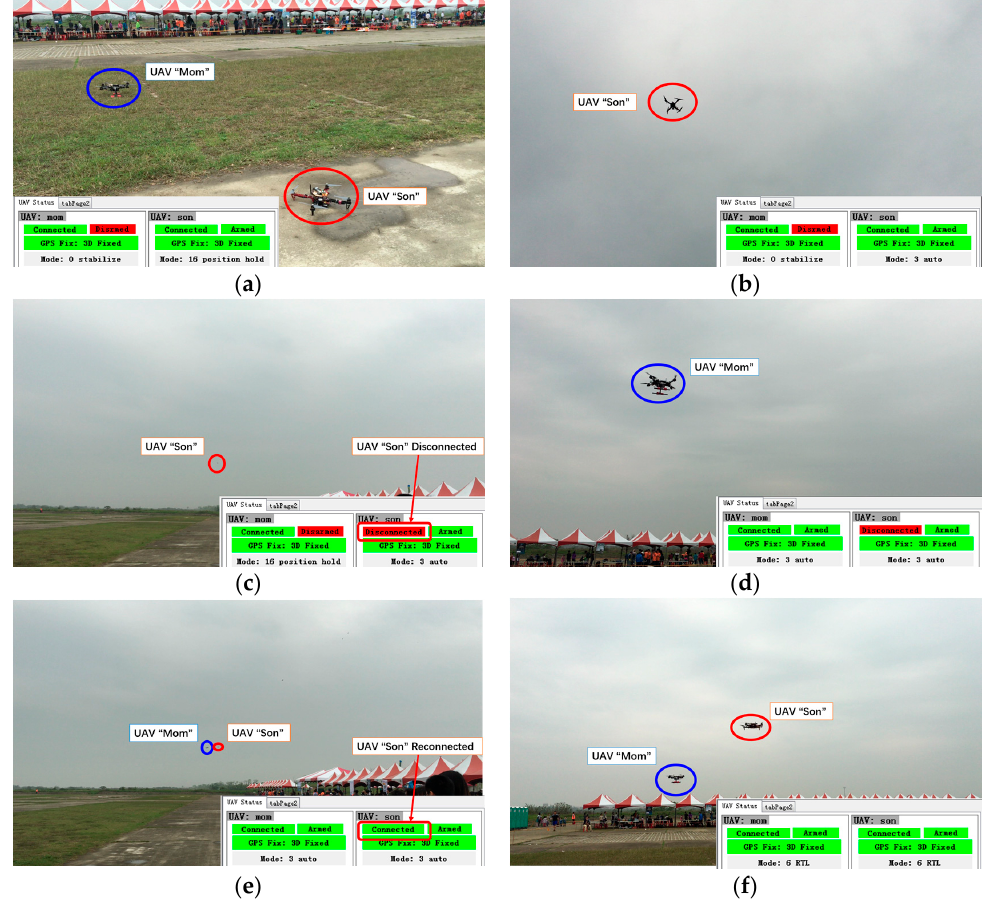
Figure 22. A rundown of flight test ( a ) Pre-takeoff setup of flight test; ( b ) UAV “Son” starts the mission; ( c ) “Son” is out of radio range and communication with it is lost; ( d ) UAV “Mom” is deployed to the relay position; ( e ) Communication with “Son” is re-established after being relayed through “Mom”; ( f ) “Mom” and “Son” return to launch position; the mission is